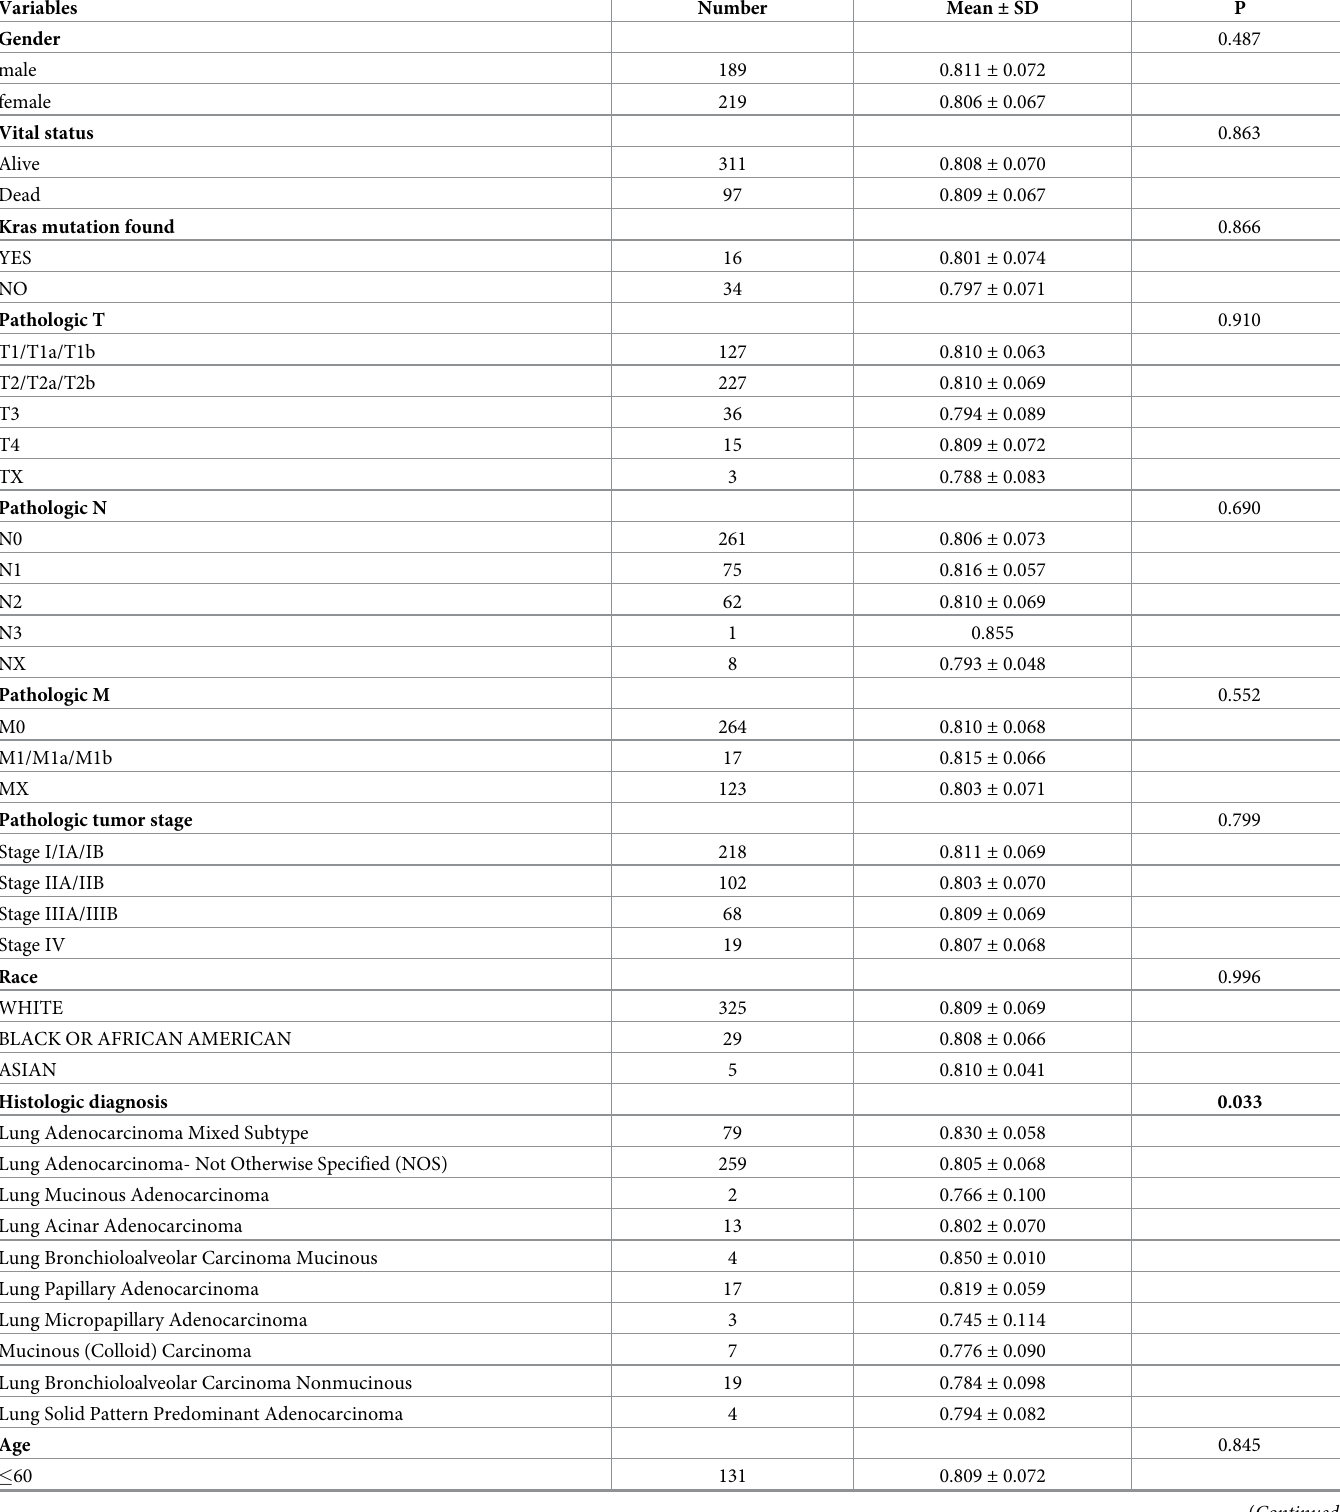
Table 3. Correlation between clinical characteristics and the methylation value of cg19810954 in ADARB1 in LUAD